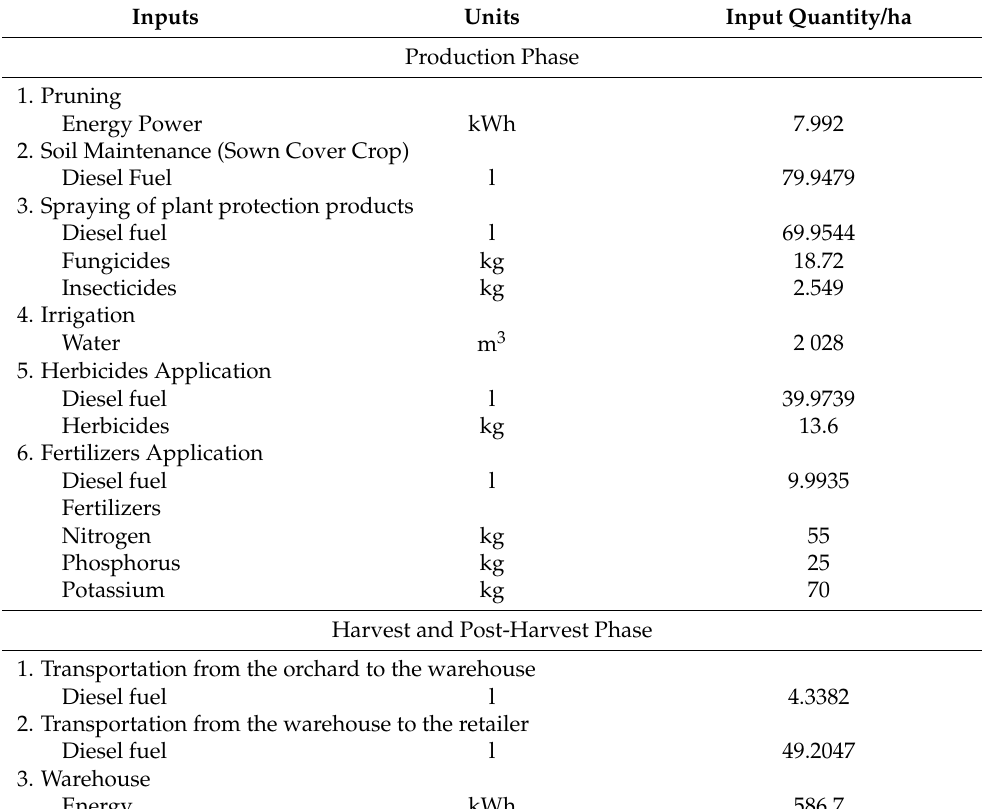
Table 2. Inputs considered in the cherries